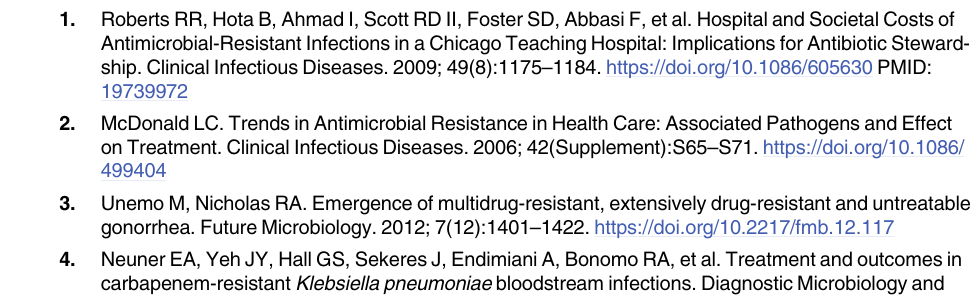
S17 Fig. Difference between equilibrium values obtained for infection dynamics in multi- deme systems as initial conditions vary. For 10 different random regular graphs with 20 demes and degree ( d ) 3, 4, or 5, treatment was allocated randomly across demes with an overall proportion treated ρ = 0.35. For each graph-treatment allocation combination, 100 different sets of initial conditions (levels of resistant and sensitive infections in each deme) were chosen uniformly at randomly, and infection dynamics were run until an equilibrium was reached as described in the Methods. The maximum difference (in matrix 2-norm, also known as L norm, Frobenius norm, or Euclidean distance) was calculated between the equilibria seen in any of 100 trials and the equilibrium values used for results reported in the main text. Very low maximum norm values suggest there is a single stable equilibrium value for each parameter set.